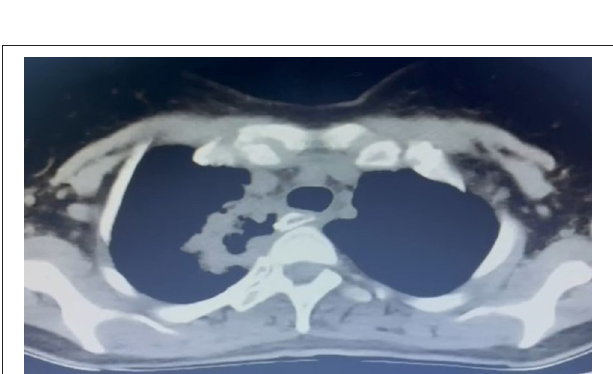
FIGURE 3 | (A) The ends of the esophagus and stomach conduit are prepared and aligned correctly. (B) Gastric perfusion can be assessed with indocyanine green. Excellent perfusion of the gastric conduit is seen. (C) An esophagotomy is performed in the esophageal tip and the nasogastric tube is visualized. (D) A small gastrostomy is performed for placement of the thicker stapler leg. (E) Anastomosis at the posterior wall is performed by combining esophageal and gastric tips using a 60-mm-thick tissue stapler. (F) The esophageal and gastric walls can be clearly visualized. ( G) Side placement of the thick tissue stapler to complete the anastomosis. (H) Visualization of final alignment of the conduit and anastomotic line.